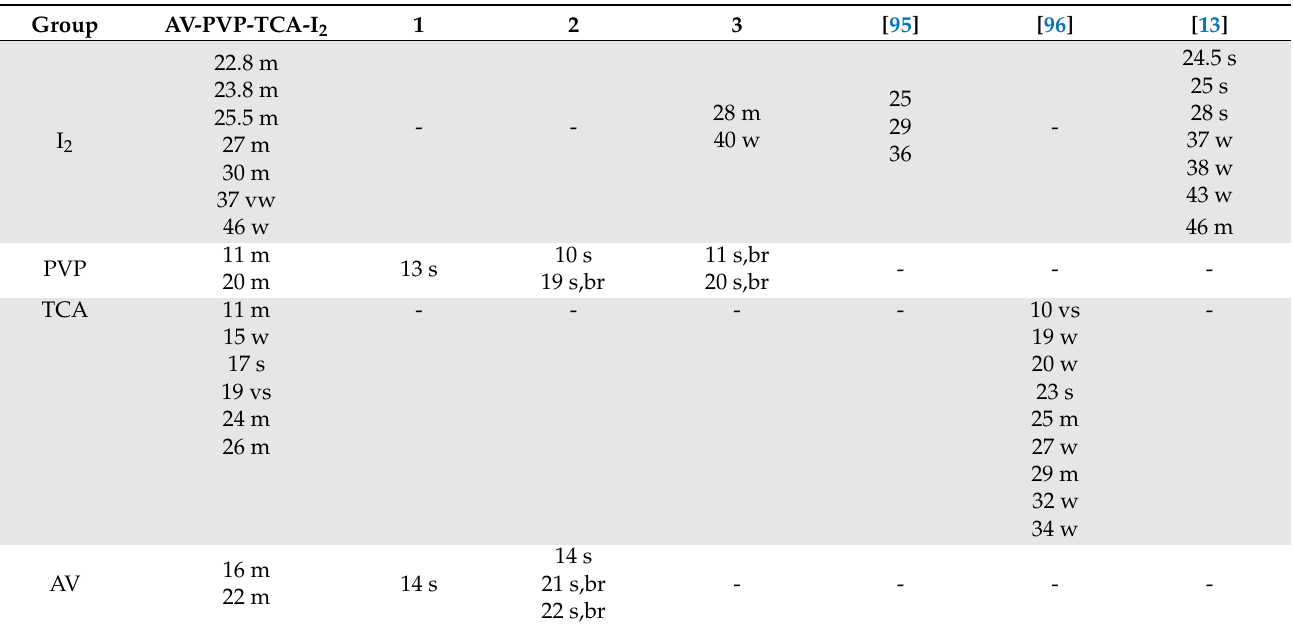
Figure 8. XRD analysis of AV-PVP-TCA-I 2 . The two main peaks at 2 θ = 17, 19° and smaller peaks at 11 and 15° belong to TCA, while others at 11 and 20° are due to PVP [41,95–100]. Further peaks reveal crystalline behavior at 2 θ = 10, 15, 16, 19, 20, 21 and 22° [41,95–100]. The small broad bands from 2 θ = 20° to 30° indicate the formation of amorphous phases after the deposition of polyiodide species into the PVP matrix (Figure 8). Iodide moieties are encapsulated into the PVP backbone and cause small but broad amorphous regions below the sharp peaks at 22.8, 23.8, 25.5, 27 and 30 (Figure 8, Table 4). Table 4. XRD analysis of the samples AV-PVP-TCA-I 2 , AV-PVP-Sage-I 2 (1), AV-PVP-I 2 (2) [41], AV-PVP-I 2 -NaI (3) [41] and in previous reports (2Theta o ).